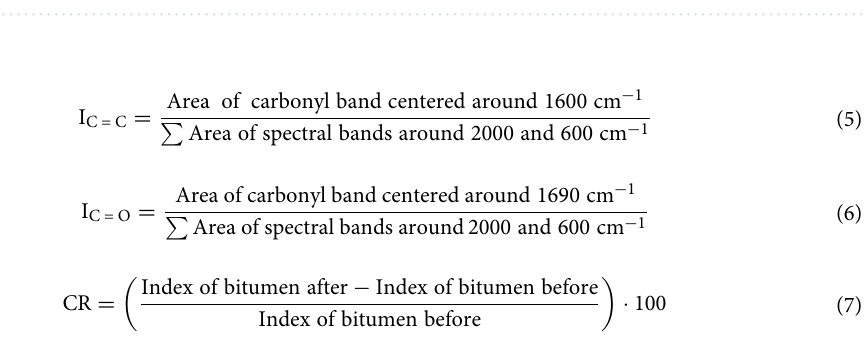
Table 1. Rate changes of chemical bands in different aging